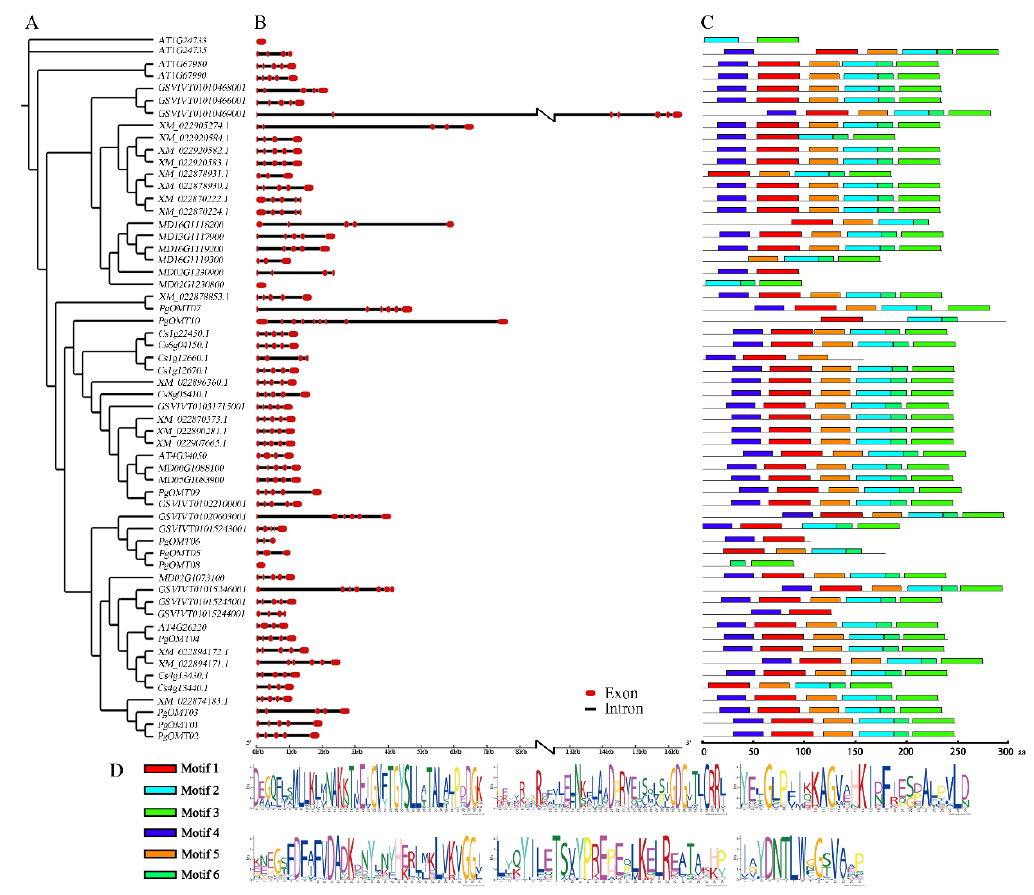
Figure 2. Phylogenetic tree ( A ), gene structures ( B ), conserved motif distribution ( C ) and 6 conserved motifs ( D ) of OMT gene from 6 species. Gene structures and protein conserved motifs were visualized by online software GSDS and MEME, respectively.